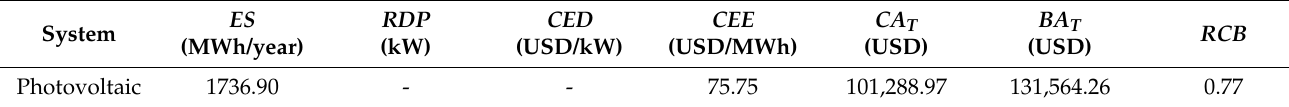
Table 10. Economic Feasibility Analysis of the PV Generation Systems.